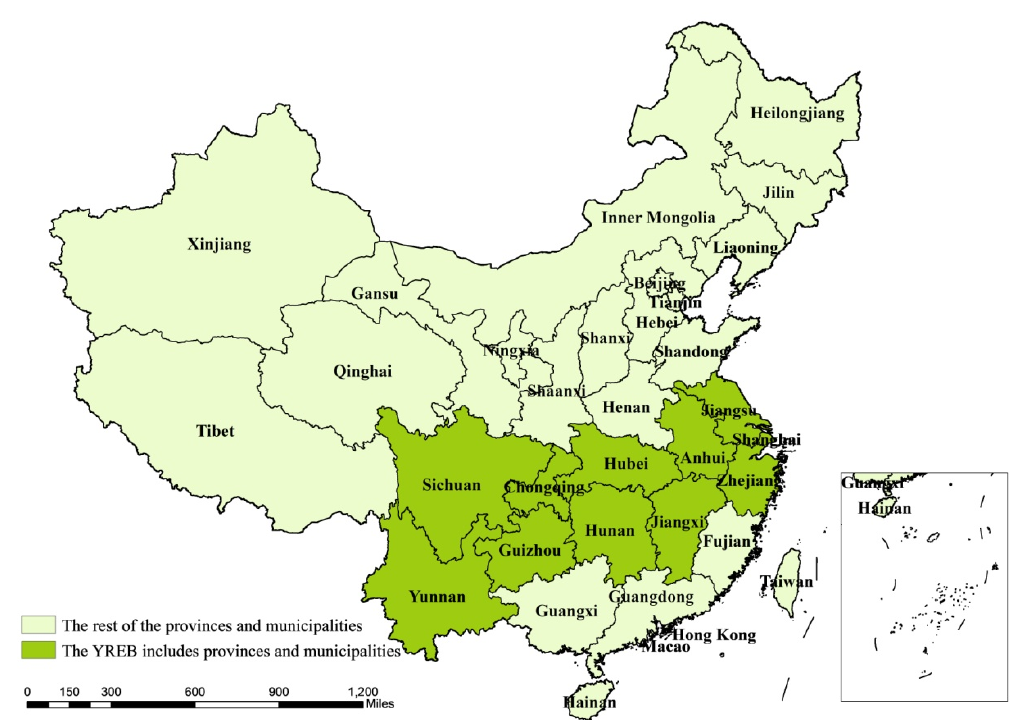
Figure 1. The Yangtze River economic belt research area (dark green).